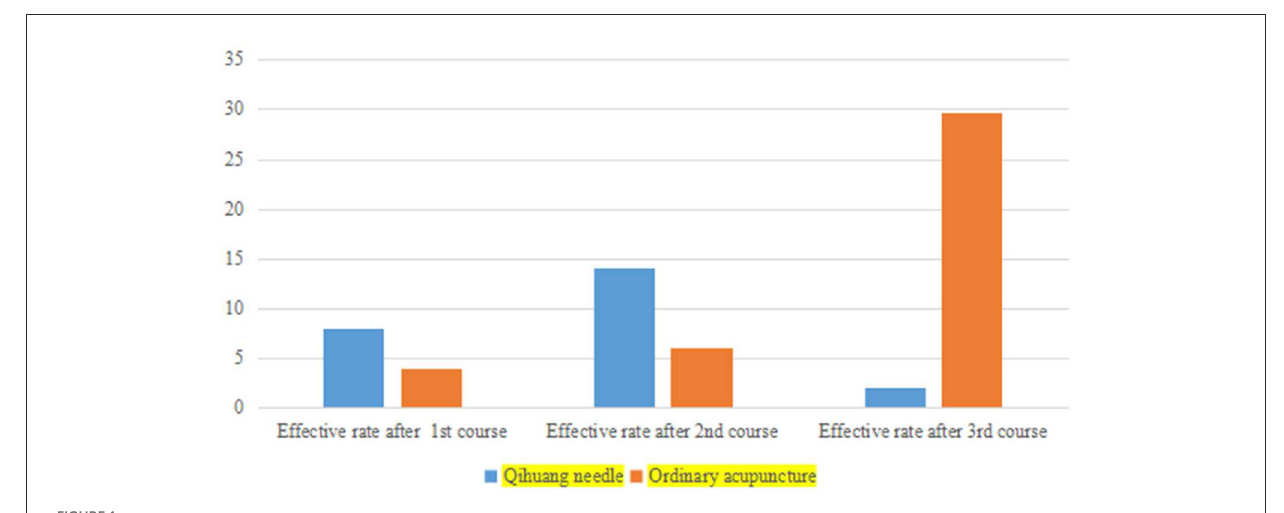
acupuncture is better than that of an ordinary treatment and can shorten the course of the